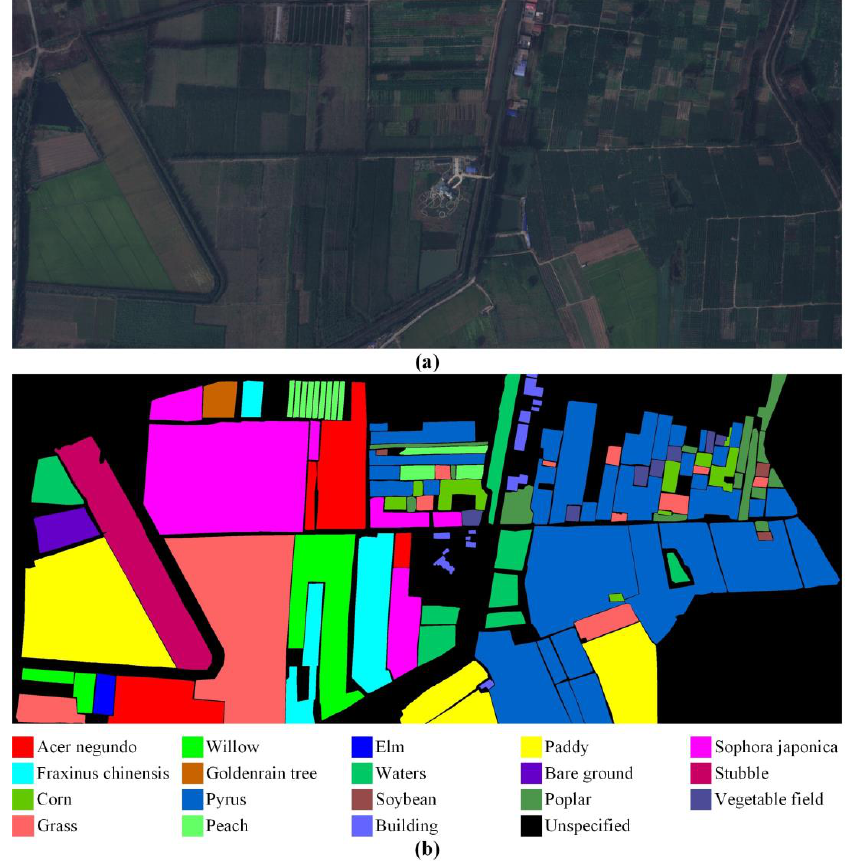
shown in Figure 3.